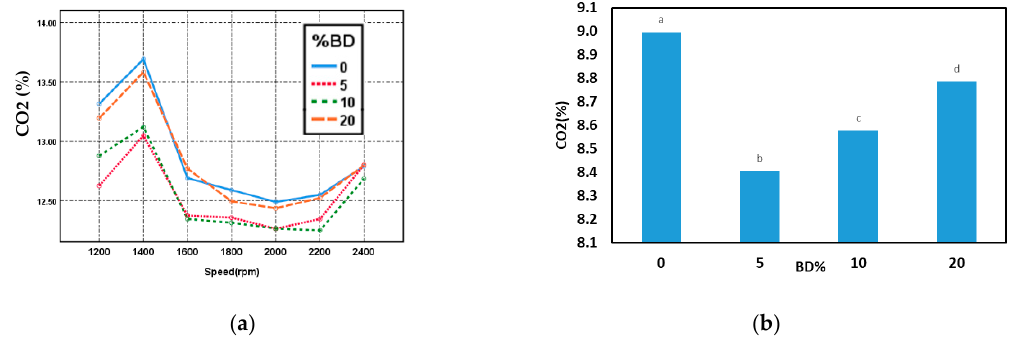
Figure 9. ( a ) CO 2 vs. S at 100% load; ( b ) mean values of total data of CO 2 for different speeds and loads. The letters a-d inside the diagram indicate significant differences ( P ≤ 0.05).